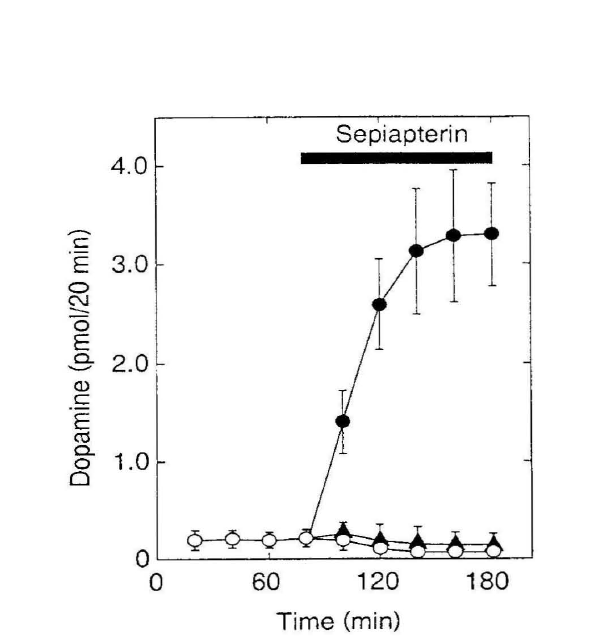
Figure 6. Effects of sepiapterin added to the perfusion fluid on DA levels in dialysates. Twenty minutes after i.p administration of saline (filled cicles) or 250 mg/ kg of a MT (filled triangles), sepiapterin (1 mM) was added to the perfusion fluid during the time indicated by a bar. Empty circles represent the control group which was given 250 mg/kg of a-MT alone. Each value is the mean ± SEM of four